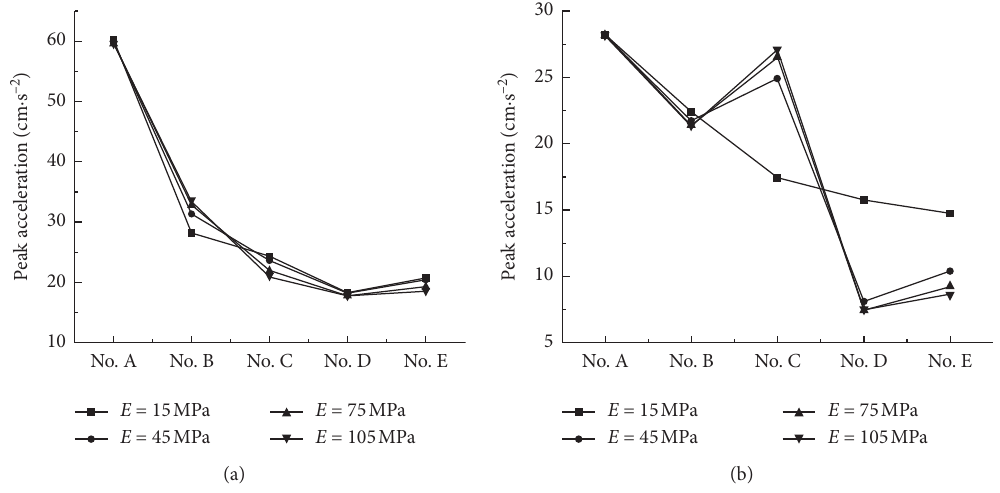
Figure 17: Influence of the elastic modulus of the fourth terrace on vibration. (a) Horizontal direction. (b) Vertical direction.